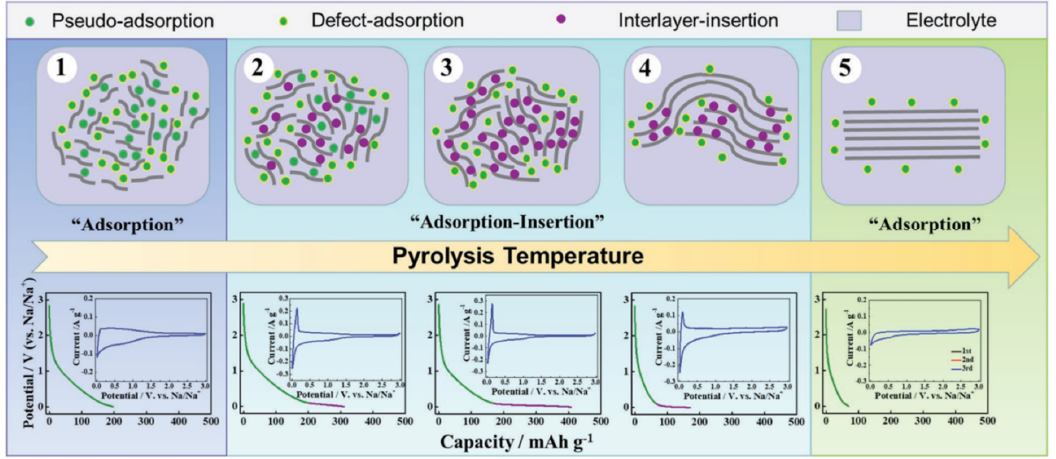
Figure 10. Schematic illustration of the extended “adsorption-intercalation” model